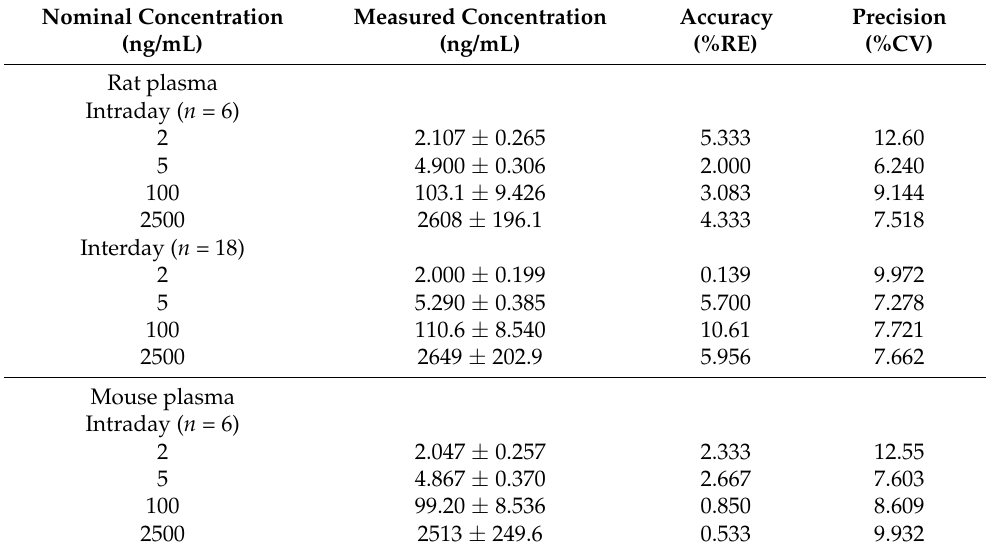
Table 1. Intra- and interday precision and accuracy of the